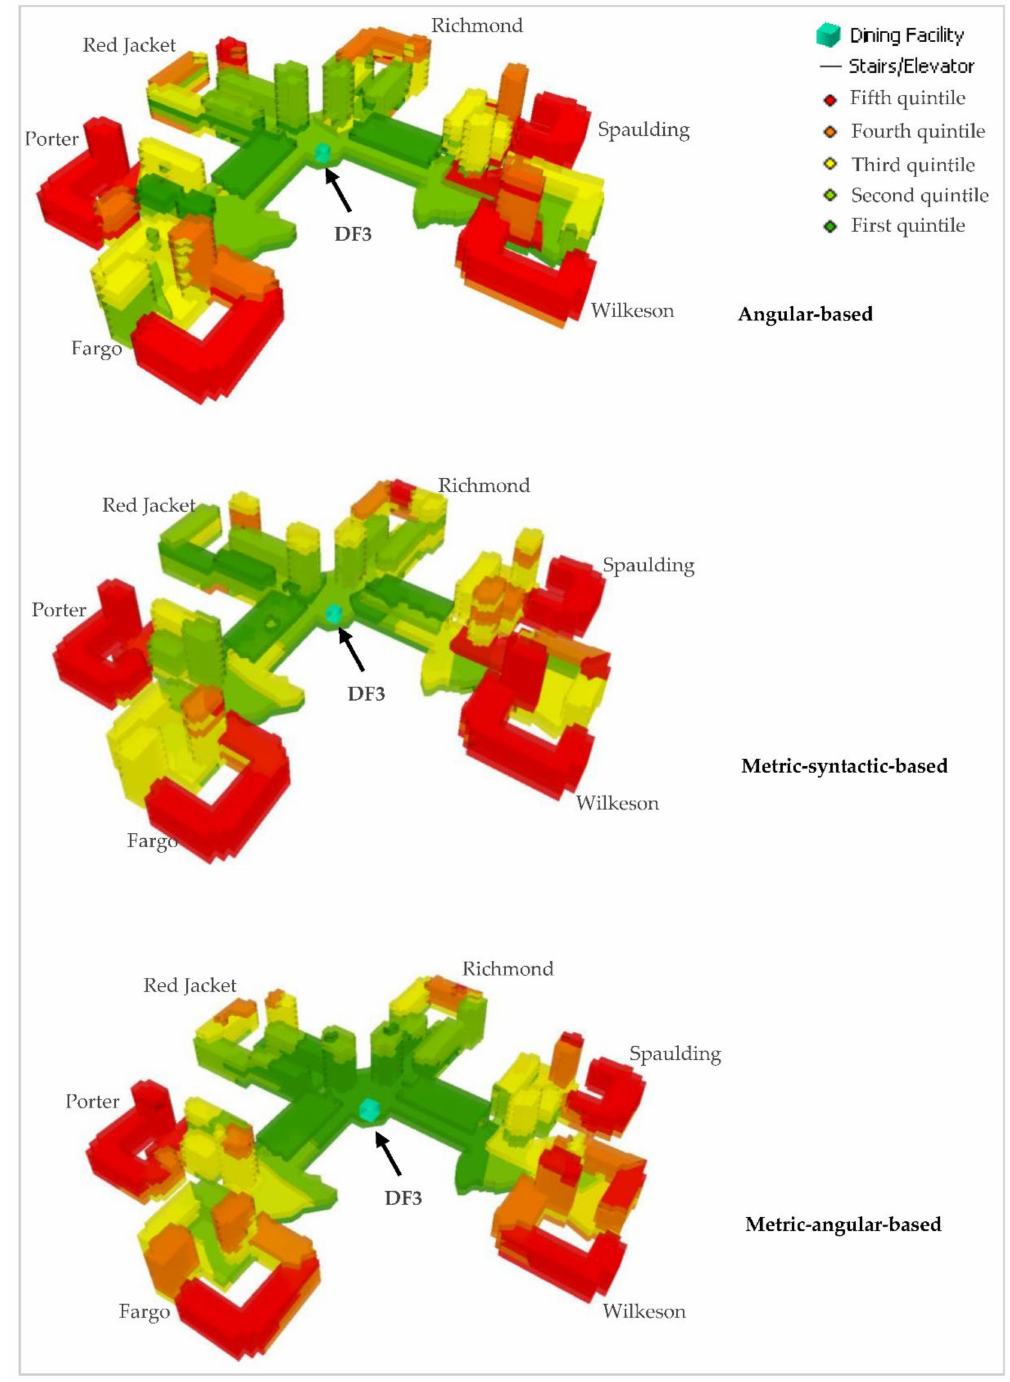
Figure 18. Angular, metric-syntactic, and metric-angular accessibility to dining facility 3: classification in